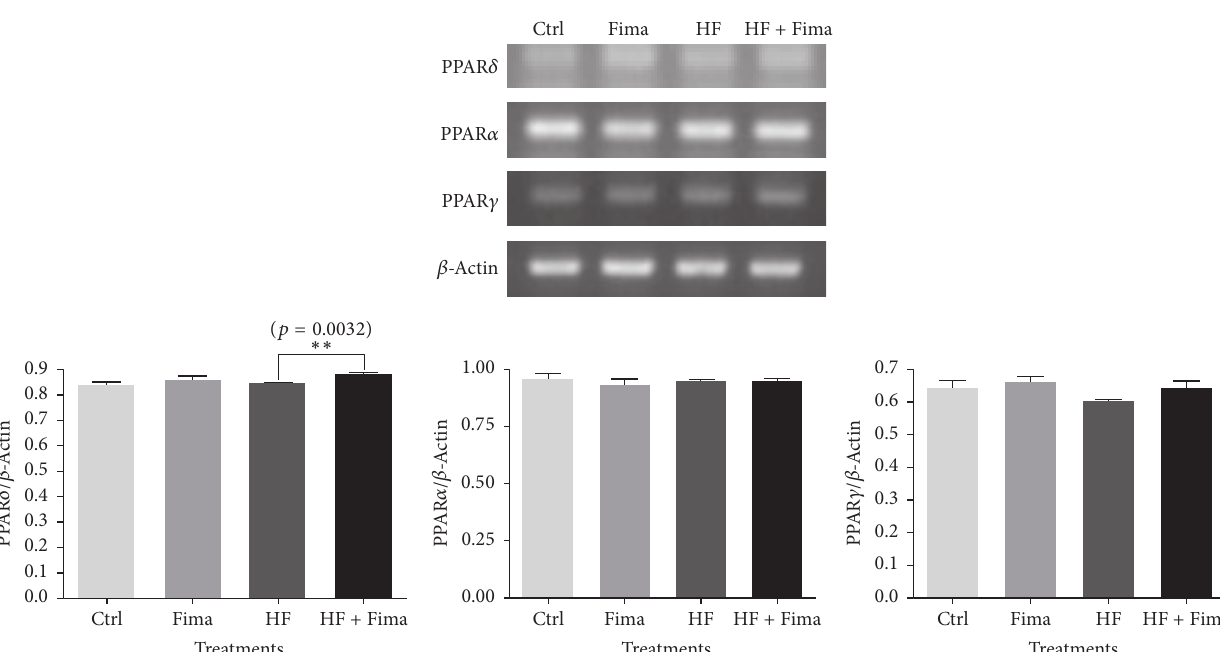
Figure 1: Peroxisome proliferator-activated receptor delta (PPAR 𝛿 ), peroxisome proliferator-activated receptor alpha (PPAR 𝛼 ), and peroxisome proliferator-activated receptor gamma (PPAR 𝛾 ) mRNA expression in HepG2 cells treated with high fatty acid and fimasartan. Total RNA was extracted from HepG2 cells treated with high fatty acid and fimasartan, and then complementary DNA (cDNA) was synthesized from the total RNA. PCR reactions for PPAR 𝛿 , PPAR 𝛼 , and PPAR 𝛾 were performed. The density of bands on agarose gel was analyzed with ImageJ program. The results are expressed as means ± SEM ( 𝑛 = 3 ). Values were statistically analyzed by unpaired t -test. All experiments were repeated three